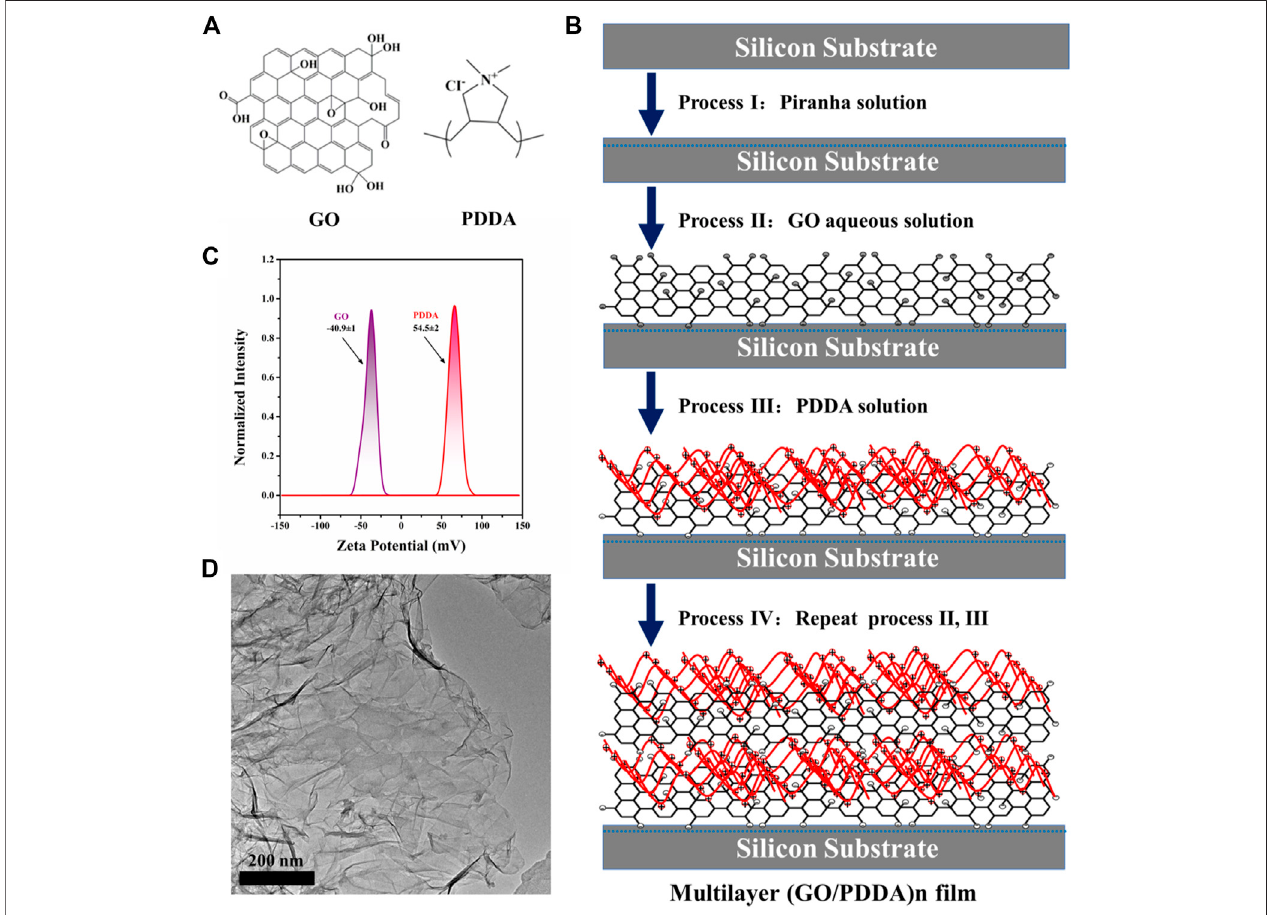
FIGURE 1 | (A) Molecular structures of graphene oxide (GO) and poly(diallyldimethylammonium chloride) (PDDA), (B) Schematic illustration of the constructing process of (GO/PDDA) n multilayer fi lms by layer-by-layer (LBL) self-assembly method, (C) ζ potential for GO and PDDA materials, (D) TEM image of GO